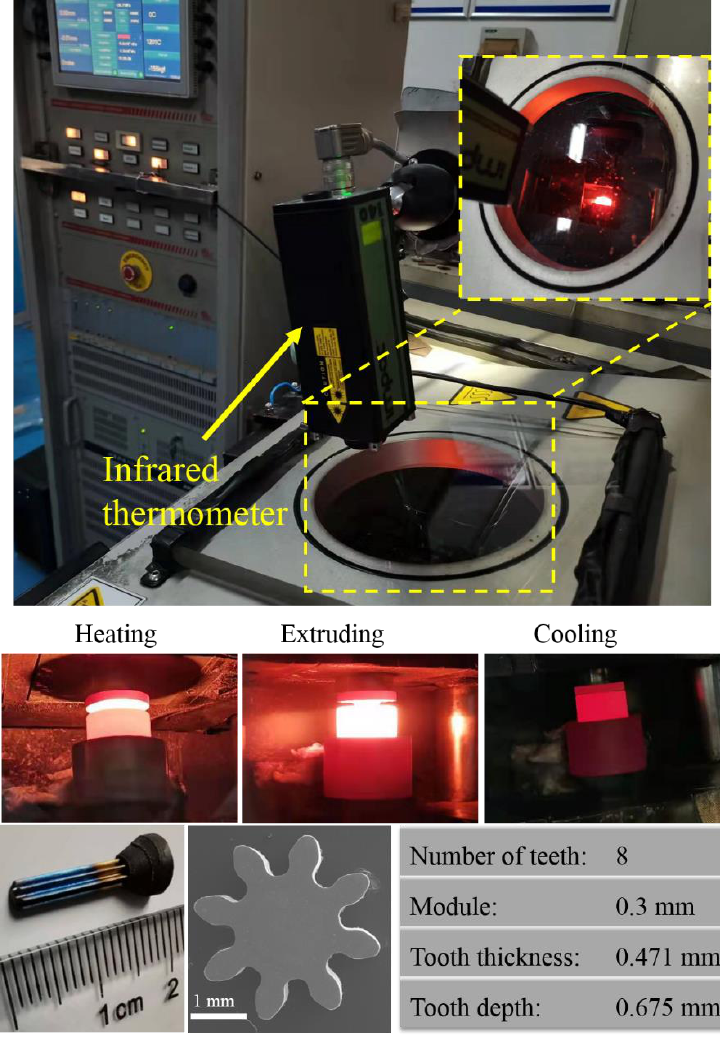
Figure 3. The forming process and the formed Ti-6Al-4V micro-gear.